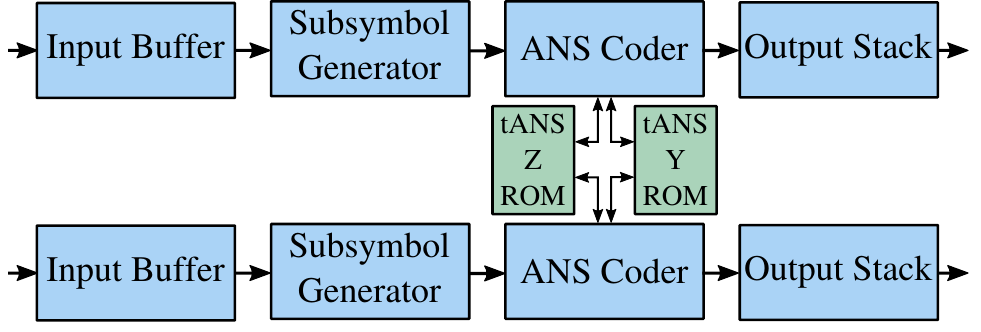
Figure 5. High-level block diagram of the double lane TSG